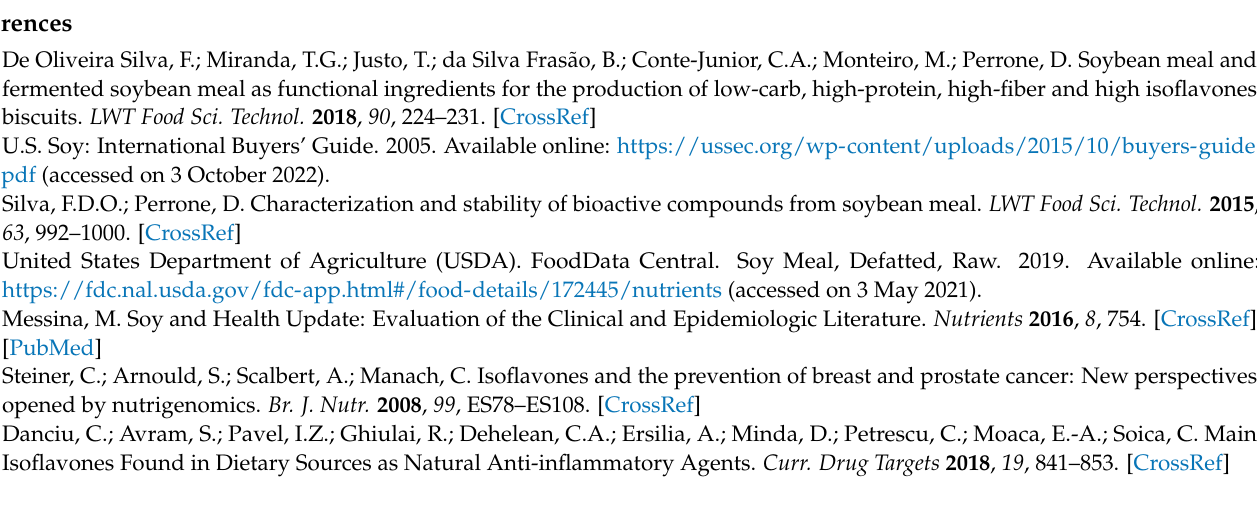
Figure S2. Chromatographic separation of isoflavones in soybean meal (SBM) (A), fermented soybean meal (FSBM) (B) and enzymatically-processed soybean meal (ESBM) (C); Table S1: Proximate (g/100 g) and mineral composition (mg/100 g) of soybean meal (SBM), fermented soybean meal (FSBM) and enzymatically-processed soybean meal (ESBM) biscuits 1 ; Table S2. Microbiological stability